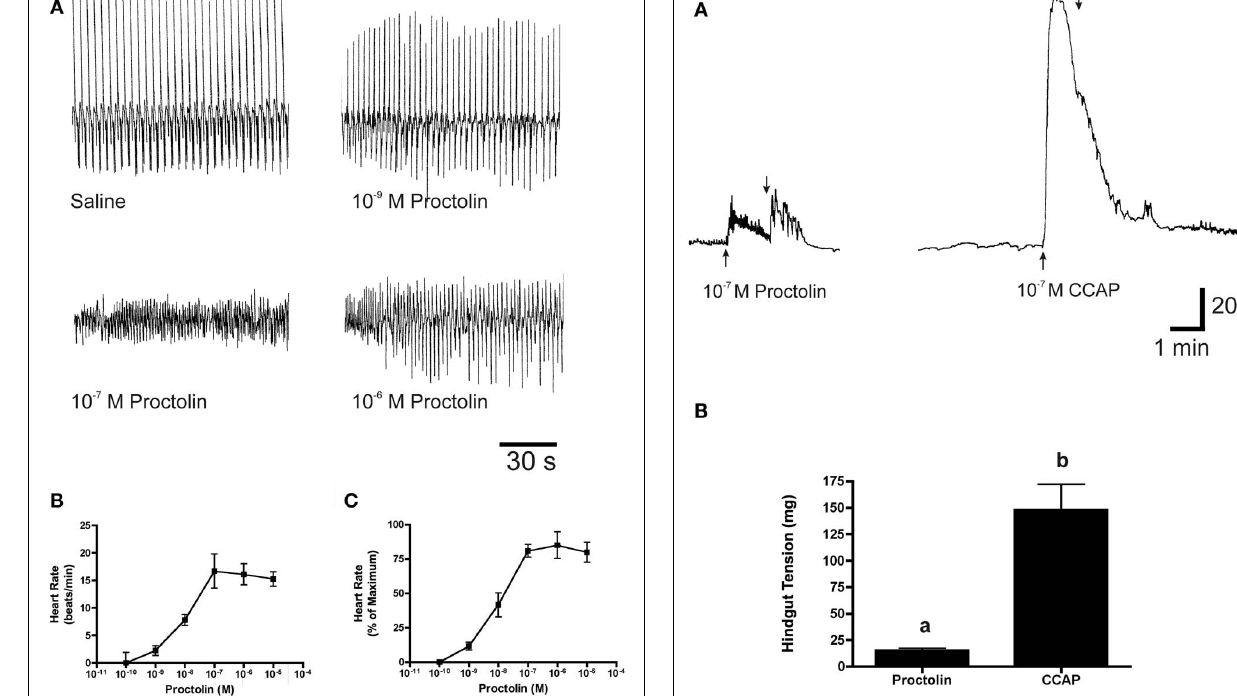
FIGURE 10 |The effects of proctolin on the heart rate of fifth instar R. prolixus . Sample traces (A) illustrate that proctolin increases the frequency of heart contractions. Dose–response curves show that proctolin increases the heart rate in a dose-dependent manner as beats/min (B) , and as the percent change in heart rate relative to maximum (C) . Data are mean ± SE, n = 6.